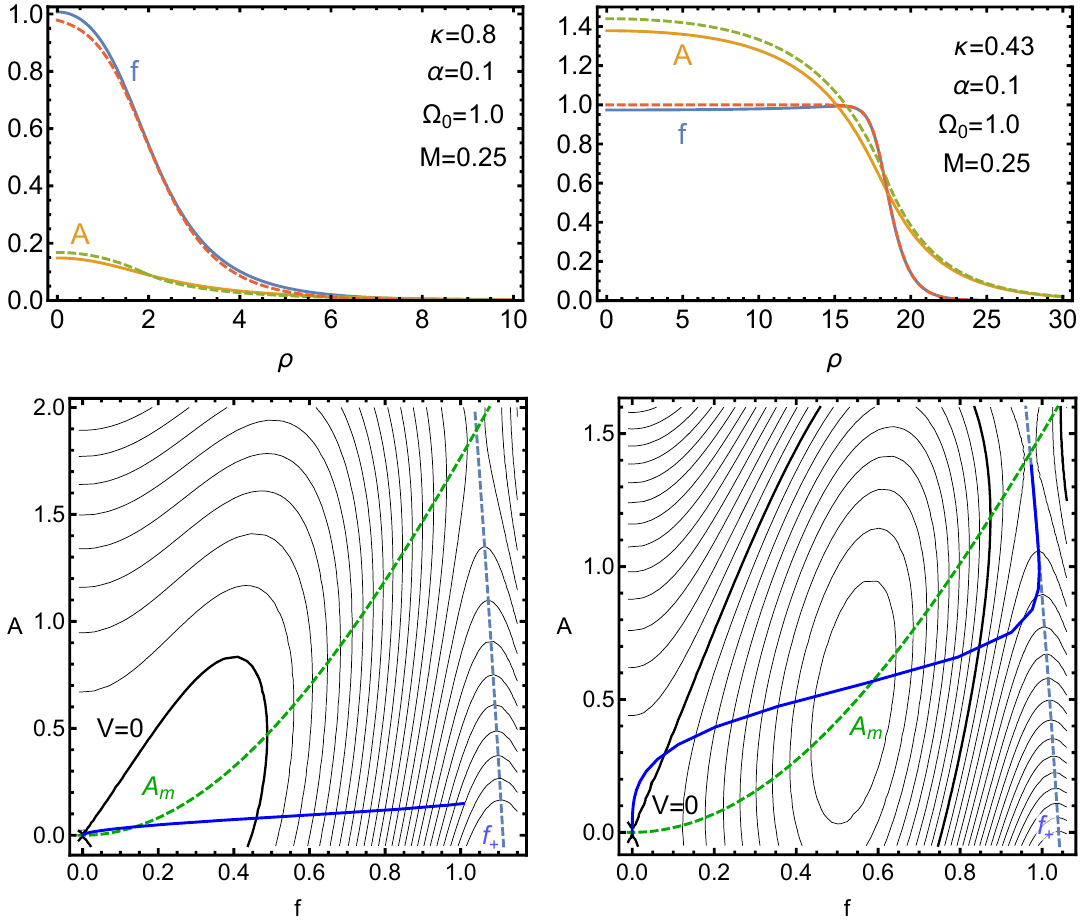
Figure 1 . Scalar and gauge field profiles for Proca Q-balls (top) and the corresponding trajectories in the potential V (bottom). Shown are the numerical f profile (blue), the numerical A profile (orange), and the analytic approximations from eqs. (3.1) and (3.2) of the same radius (dashed). A thick (thin) wall Q-ball is shown on the left (right). The values of the f maximum f + (blue) and A minimum A m (green) are shown with dashed